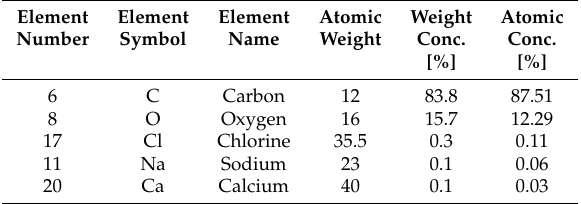
Table 4. Chemical structure of a specimen of hybrid resin sample of type 2, taken from sample